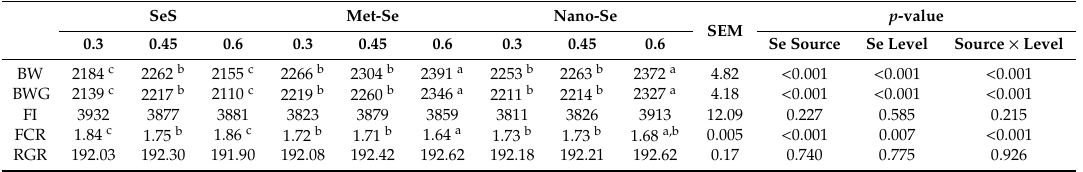
Table 2. E ff ects of dietary sources and levels of Se (mg / kg) on growth performance of broilers over 38 days. SeS